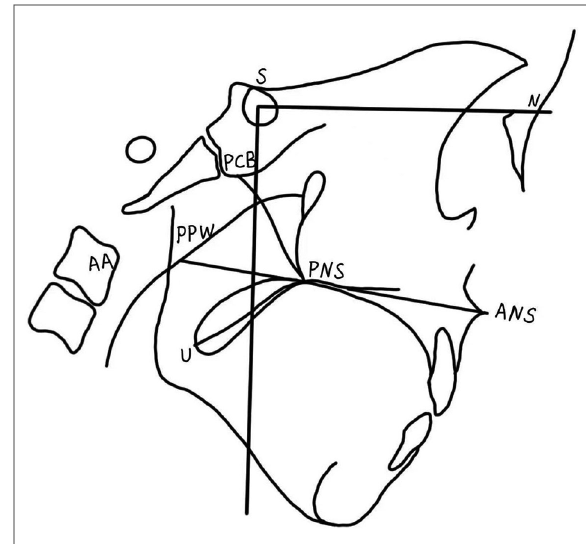
FIGURE 1 Cephalometric landmarks and velopharyngeal measures. ANS, anterior nasal spine; PNS, posterior nasal spine; PPW, posterior pharyngeal wall; N, nasion; S, center of the sella turcica; PCB, pterygoid cranial base; AA, atlas; U, uvula, tip of the uvula when at